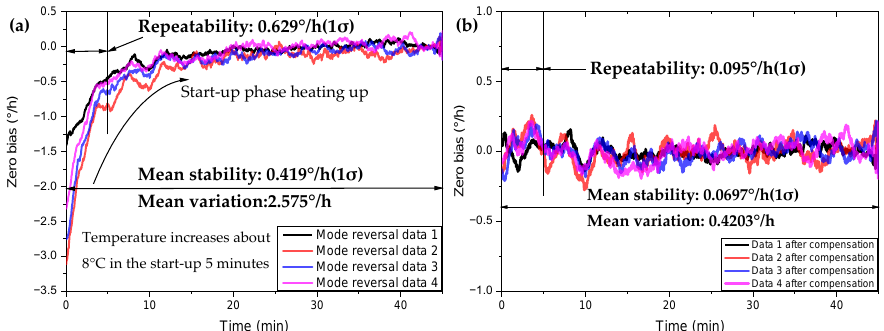
Figure 9. −2 0~20 °C temperature cycle, under the condition of 4 °C/min temperature change rate, Figure 9. − 20~20 ◦ C temperature cycle, under the condition of 4 ◦ C/min temperature change rate, the zero bias of the mode reversal, and the zero-bias comparison of the mode reversal combined with multiple regression compensation. ( a ) Working in FTR mode before compensation. ( b ) Working in FTR mode after compensation. ( c ) Working in mode reversal before compensation. ( d ) Working in mode reversal after compensation.